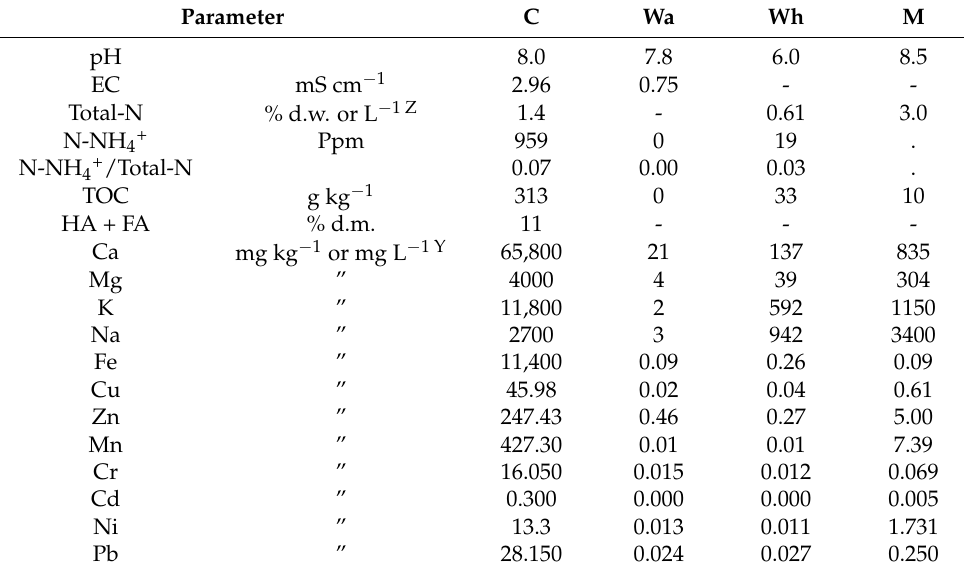
Table 1. Chemical and physical characteristics of the source materials used to produce the